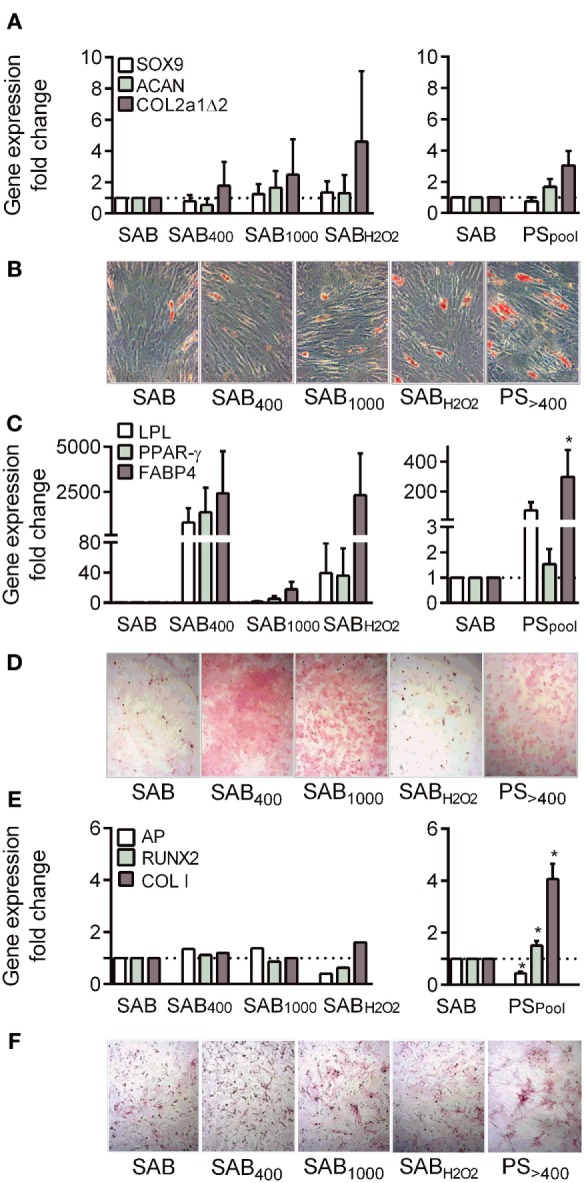
Systemic sclerosis (SSc) patient serum increased osteogenic differentiation potential of MSCs. (A) Chondrogenic differentiation of MSCs cultured with human serum AB (SAB) or oxidized SAB (SAB400, SAB1000, and SABH2O2; n = 3 for each condition) or SSc patient serum (n = 13) at day 21. Chondrogenesis was assessed by measuring expression level of specific genes: sex-determining region Y-box9 (SOX9), aggrecan (ACAN), and type II collagen variant B (COL2a1Δ2) by RT-qPCR. (B) Representative photographs of MSCs depicted in (C) and stained with Oil Red O. (C) Adipogenic differentiation of MSCs cultured with human SAB or oxidized SAB (SAB400, SAB1000, and SABH2O2; n = 3 for each condition) or SSc patient serum (n = 13) at day 21. Adipogenesis was assessed by measuring expression level of specific genes: lipoprotein lipase (LPL), peroxisome proliferator-activator receptor (PPAR)-γ, and fatty acid binding protein (FABP)4 by RT-qPCR. (D) Representative photographs of MSCs depicted in (E) and stained with Alizarin Red S. (E) Osteogenic differentiation of MSCs cultured with human SAB or oxidized SAB (SAB400, SAB1000, and SABH2O2; n = 3 for each condition) or SSc patient serum (n = 13) at day 21. Osteogenesis was assessed by measuring expression level of specific genes: Runt-related transcription factor (Runx)2, alkaline phosphatase (AP), and type I collagen (Col I) by RT-qPCR. (F) Representative photographs of MSCs depicted in(E) and stained for AP detection. Data were normalized to 1 for MSCs in SAB-containing medium. *p < 0.05 versus SAB at same time point.